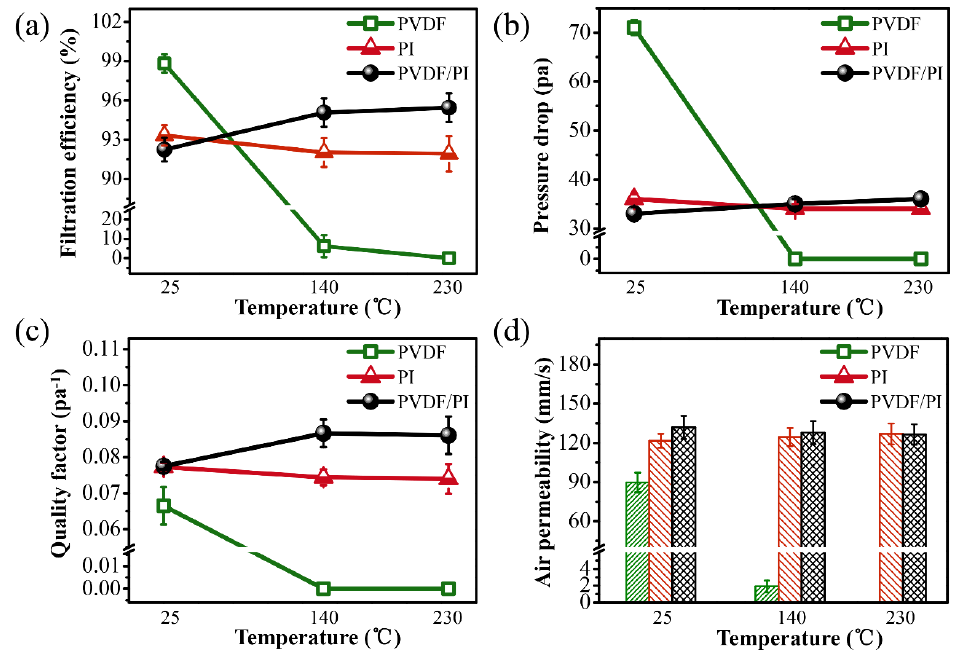
Figure 6. Filtration efficiency ( a ), pressure drop ( b ), quality factor (QF) ( c ), and air permeability ( d ) of PVDF, PI single-component fiber membrane and PVDF/PI bicomponent fiber membrane at 25 ◦ C, 140 ◦ C and 230 ◦ C, respectively. Table 1. Maximum pore size and average pore diameter of PVDF, PI, and PVDF/PI at 25 ◦ C, 140 ◦ C and 230 ◦ C, respectively.